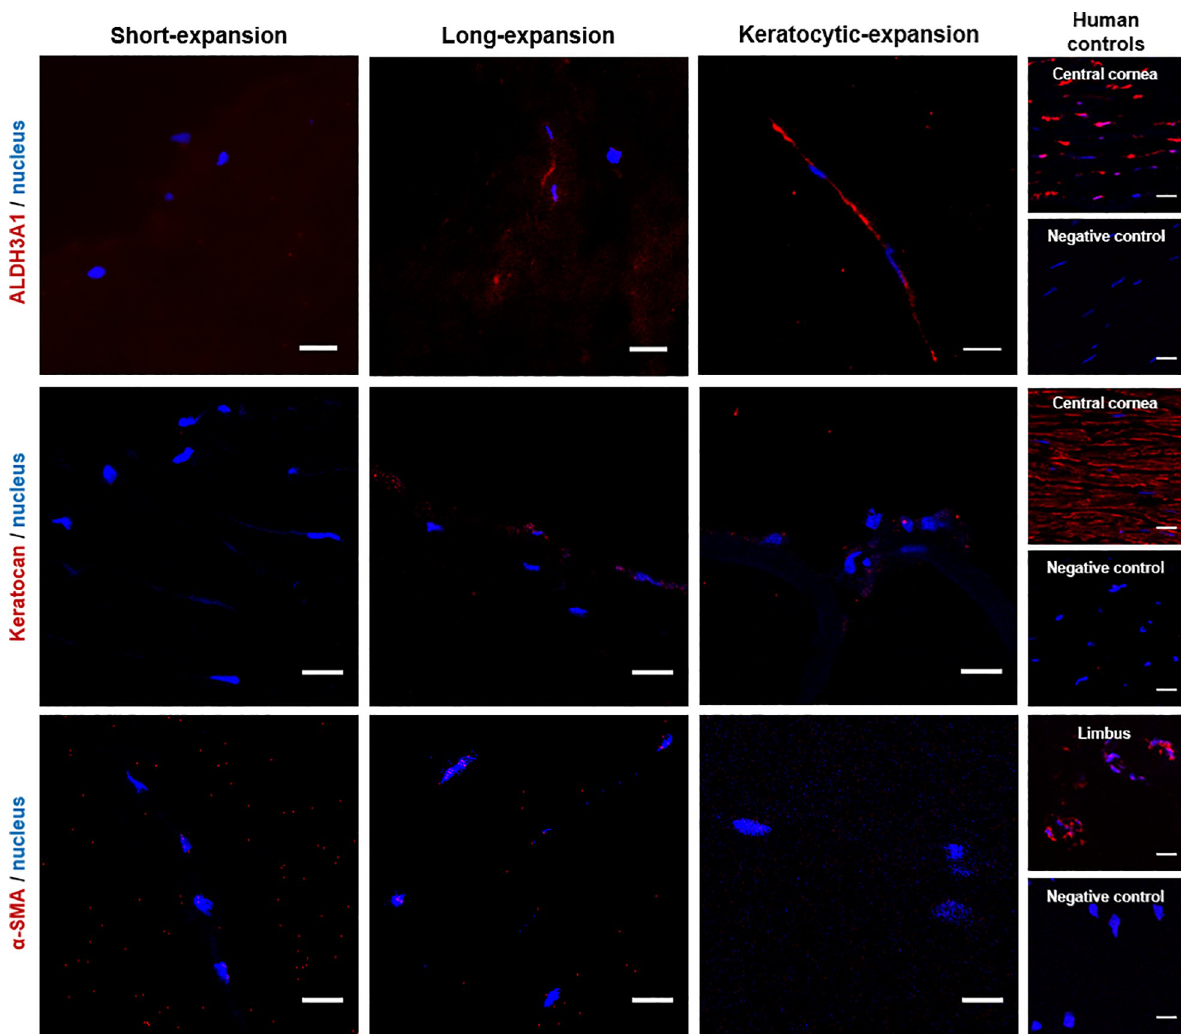
Fig 5. Phenotype of keratocytes in the scaffold. Keratocyte markers, ALDH3A1 and keratocan. Fibrotic marker α -SMA. Nucleus, DAPI nuclear staining (Scale bar = 20 μ m).